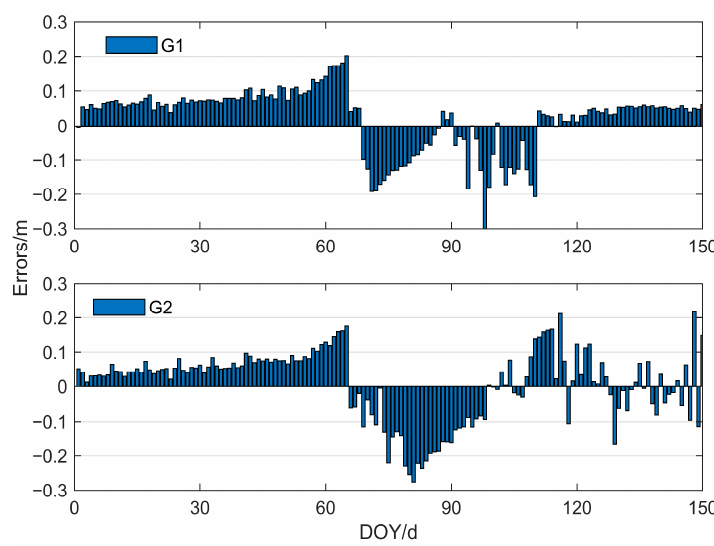
Figure 13. Retrieval errors of wheat height with GPS.